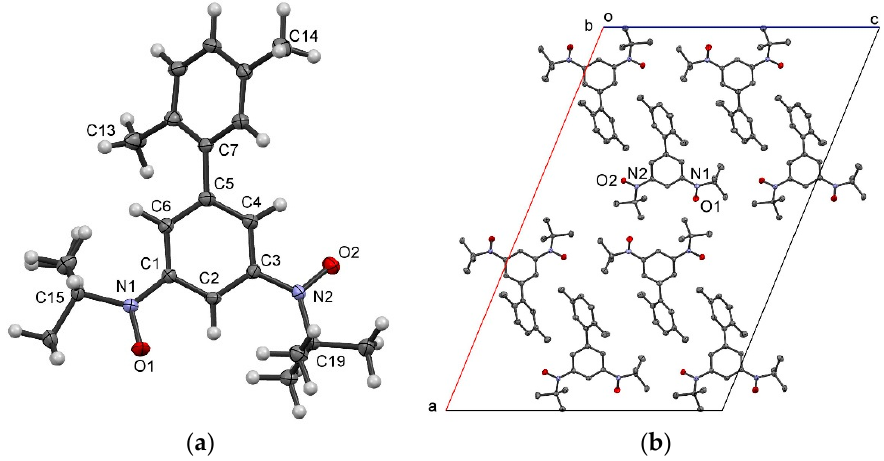
Figure 3. ( a ) Molecular structure and ( b ) molecular arrangement in the crystals of β -25MeBPBN. Selected atomic numbering is also shown. Hydrogen atoms are omitted in (b).